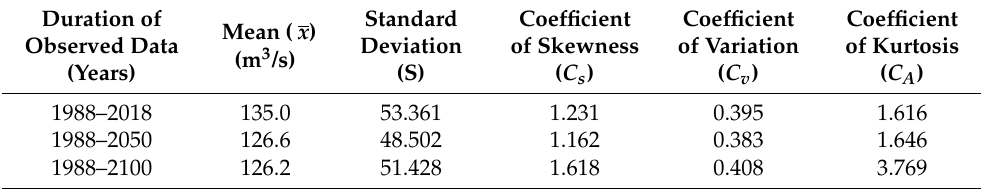
Table 4. Basic statistics for Gimhae rainfall station using RCP 4.5 scenario.